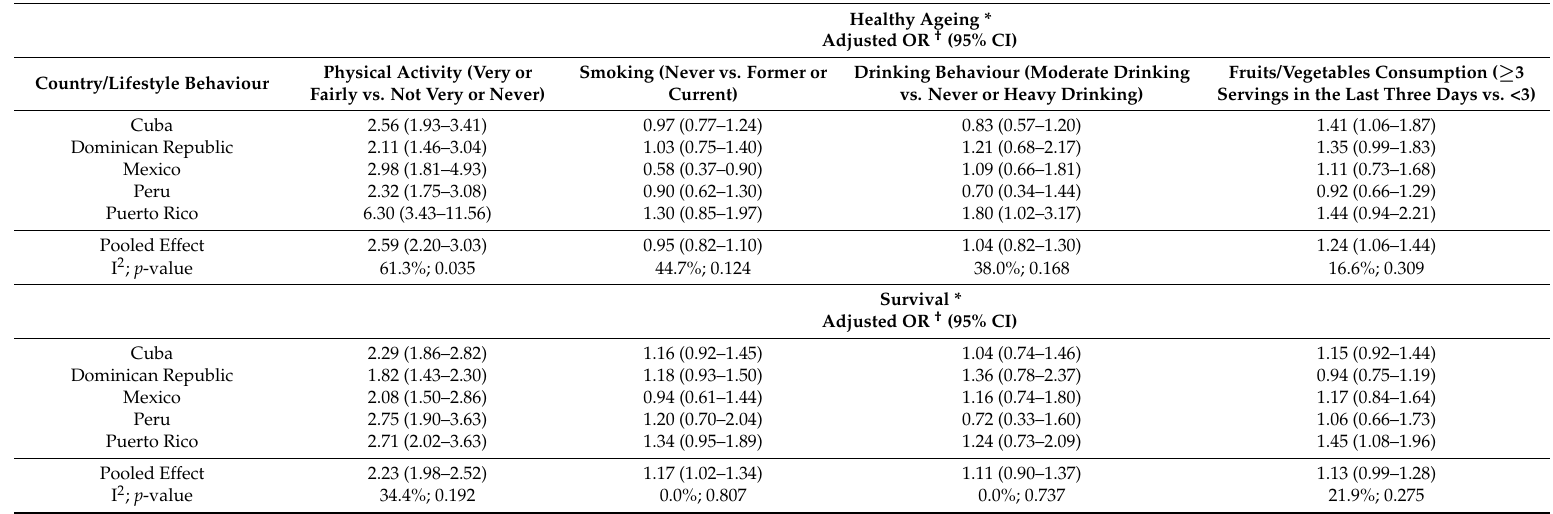
Country/Lifestyle Behaviour